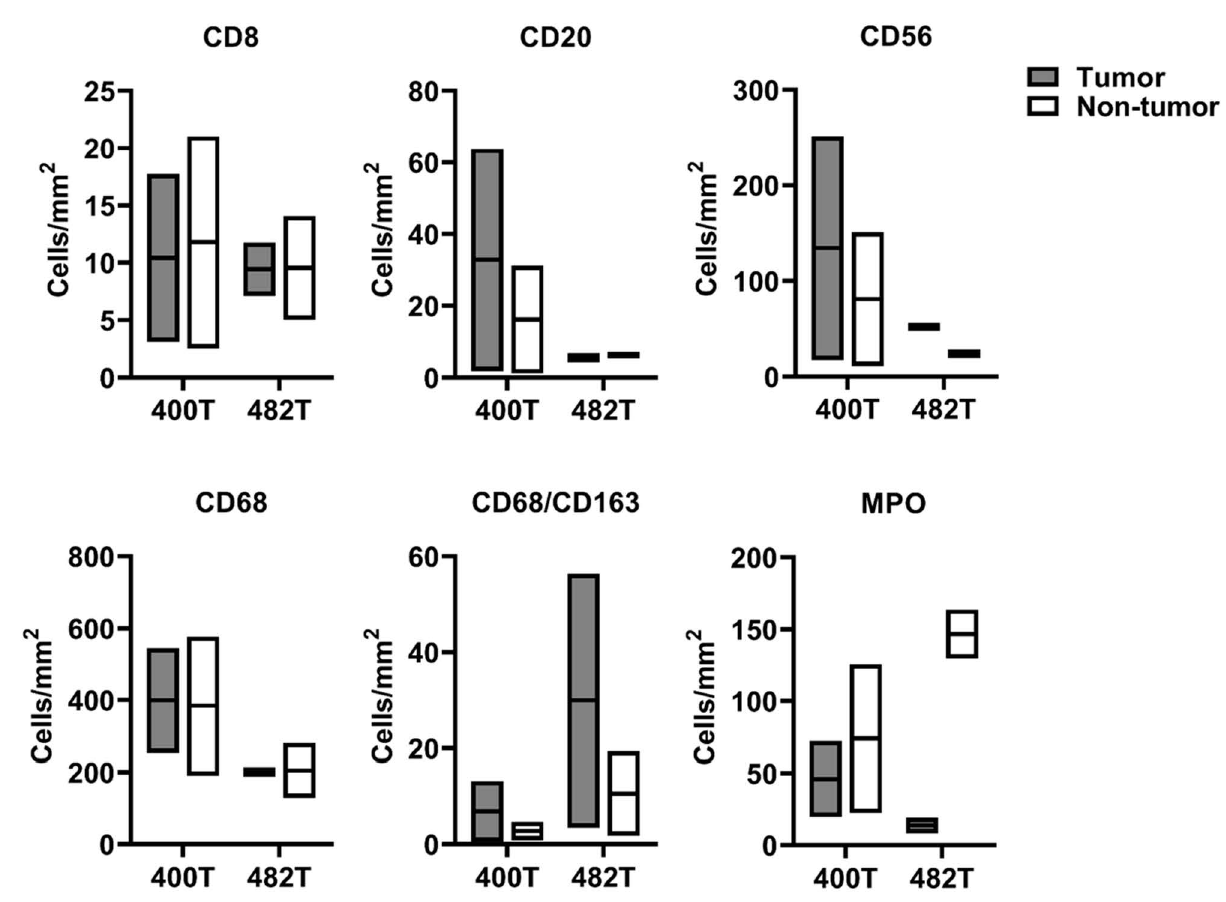
Figure 8. Infiltration of immune cells upon therapy with dinutuximab. Cell densities of cytotoxic T cells (CD8), B cells (CD20), NK cells (CD56), macrophages (CD68), CD163-positive (“M2”) macrophages, and neutrophils (MPO) were assessed by quantitative digital image analysis before (400T) and after (482T) dinutuximab therapy. Data is shown as min/max with mean for two tumor regions per time point. Representative stainings can be found in Supplemental Figure